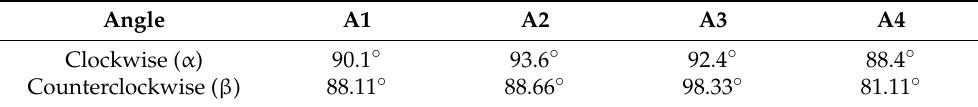
Table 3. Robot angle deviation.